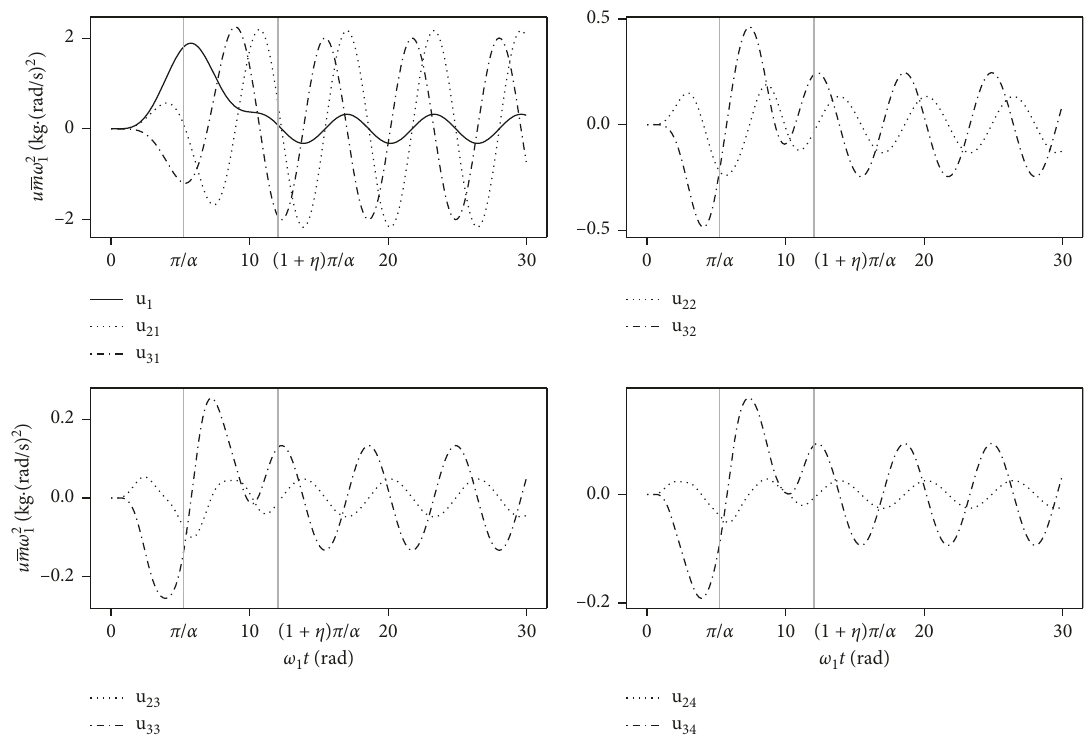
Figure 4: Comparisons of dynamic responses of the simply supported beam under different distributed force.